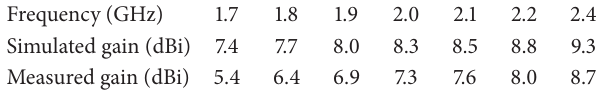
Table 1: Simulated and measured antenna